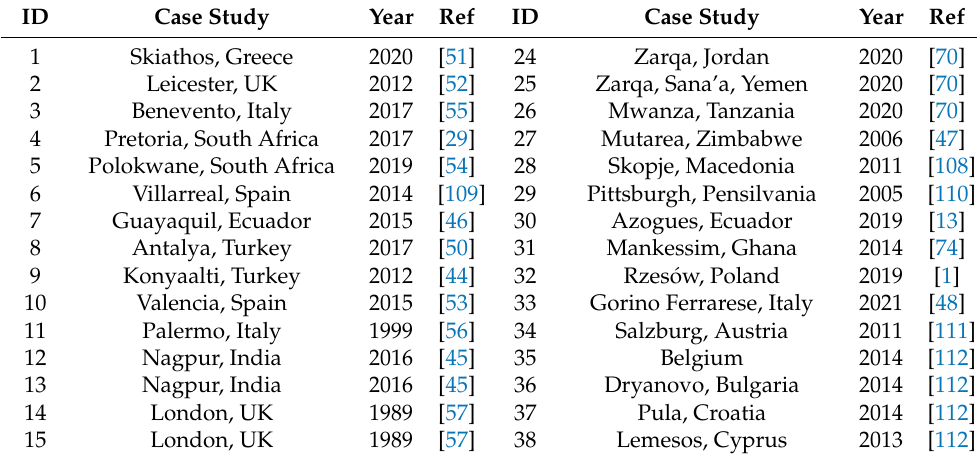
Table 6. Information of the studied